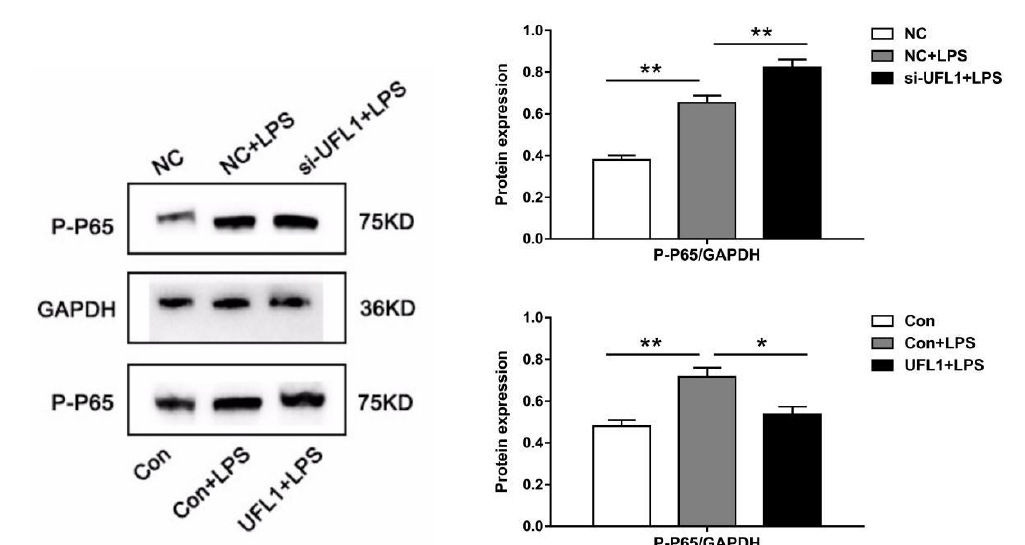
Figure 6. UFL1 inhibits phosphorylation of NF- κ B p-p65. E ff ect of Ufl1 siRNA and Ufl1 overexpression plasmid on the protein expression of p-p65 in bGCs. Data are presented as the means ± thestandarderrors of the mean (SEM) of three independent experiments. ∗ p < 0.05; ∗∗ p <